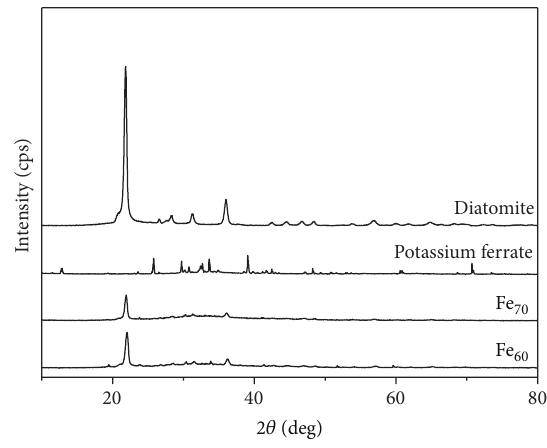
Figure 1: XRD patterns of Fe 70 , Fe 60 , K 2 FeO 4 , and diatomite